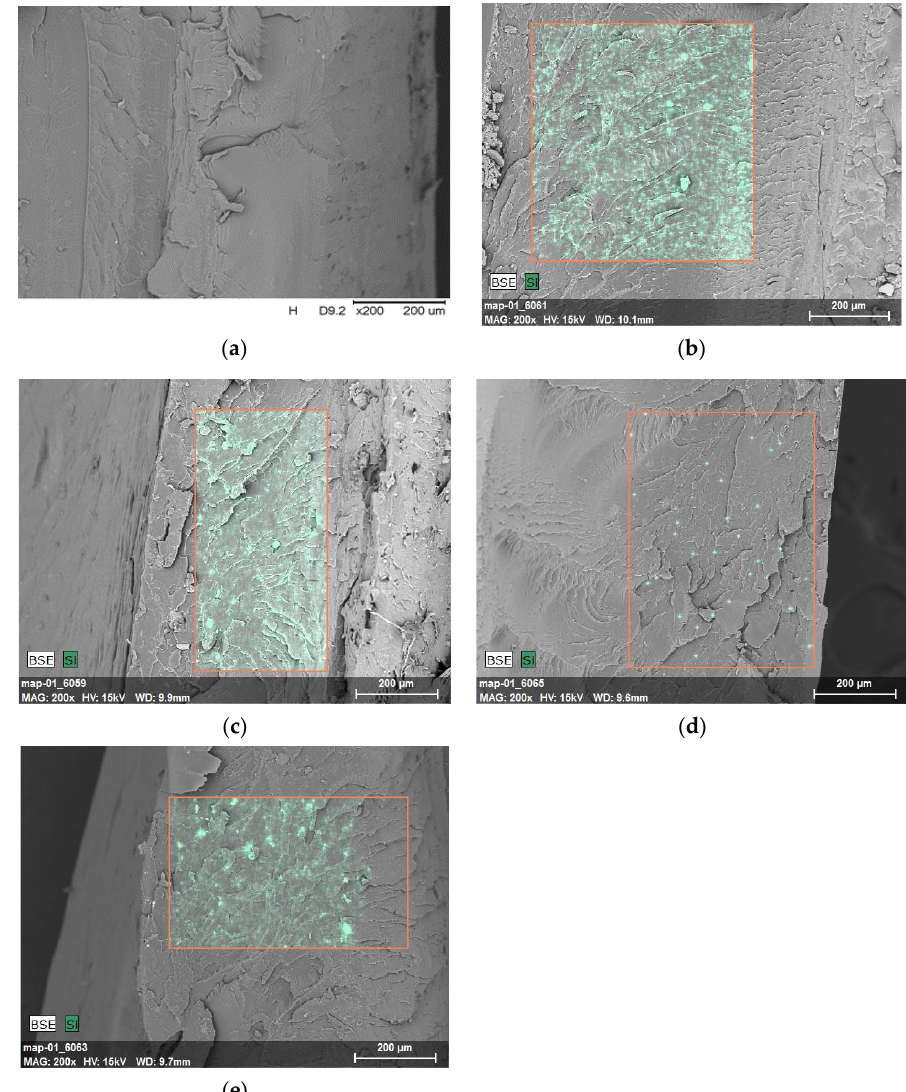
Figure 7. SEM micrographs with an EDS attachment of PET-G polymer and composites based on PET-G: ( a ) PET-G, ( b ) PET-G/3%S, ( c ) PET-G/3%B, ( d ) PET-G/3%L, and ( e ) PET-G/1.5%L/1.5%B. The red contour marks the area subjected to EDS analysis, which was performed in order to observe the degree of filler dispersion and the distribution of the silicon element.